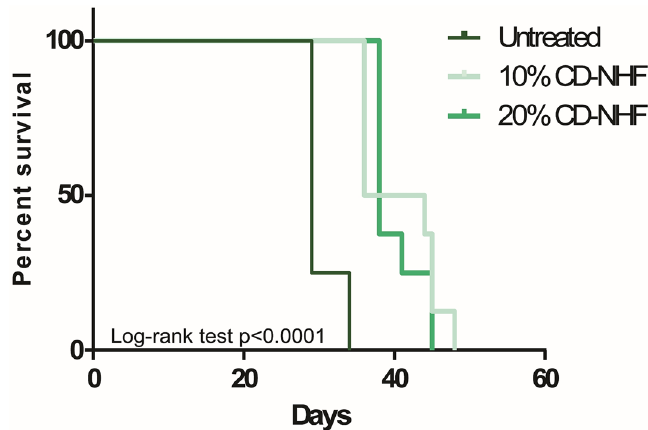
Figure 8. Univariate survival analysis between untreated and treated